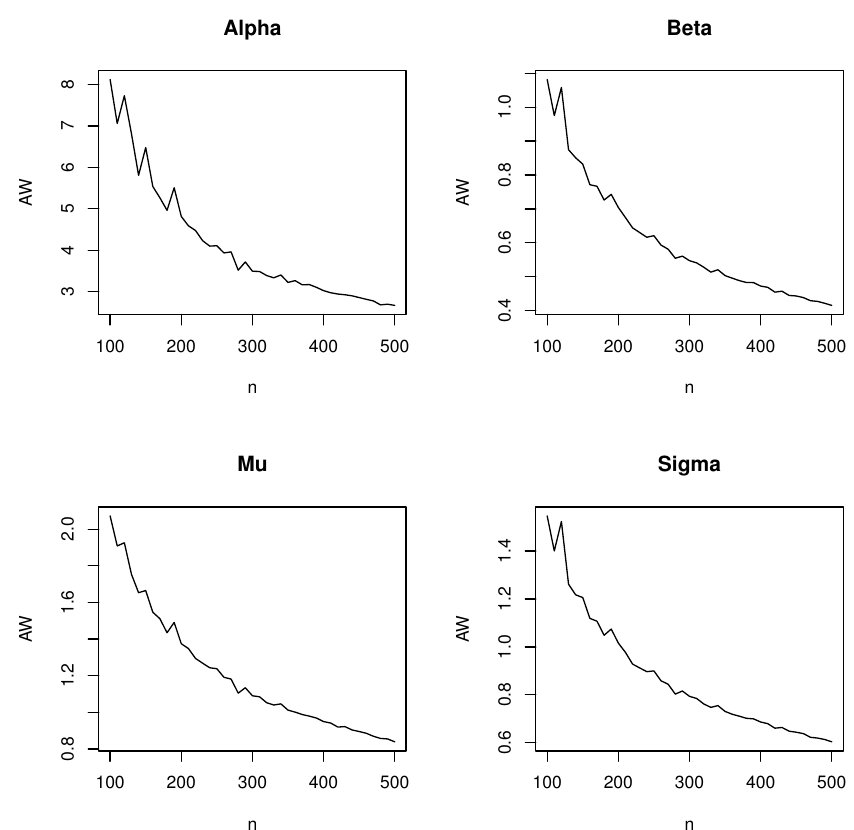
Figure 7. AW of 95% confidence intervals of the vector parameter Θ